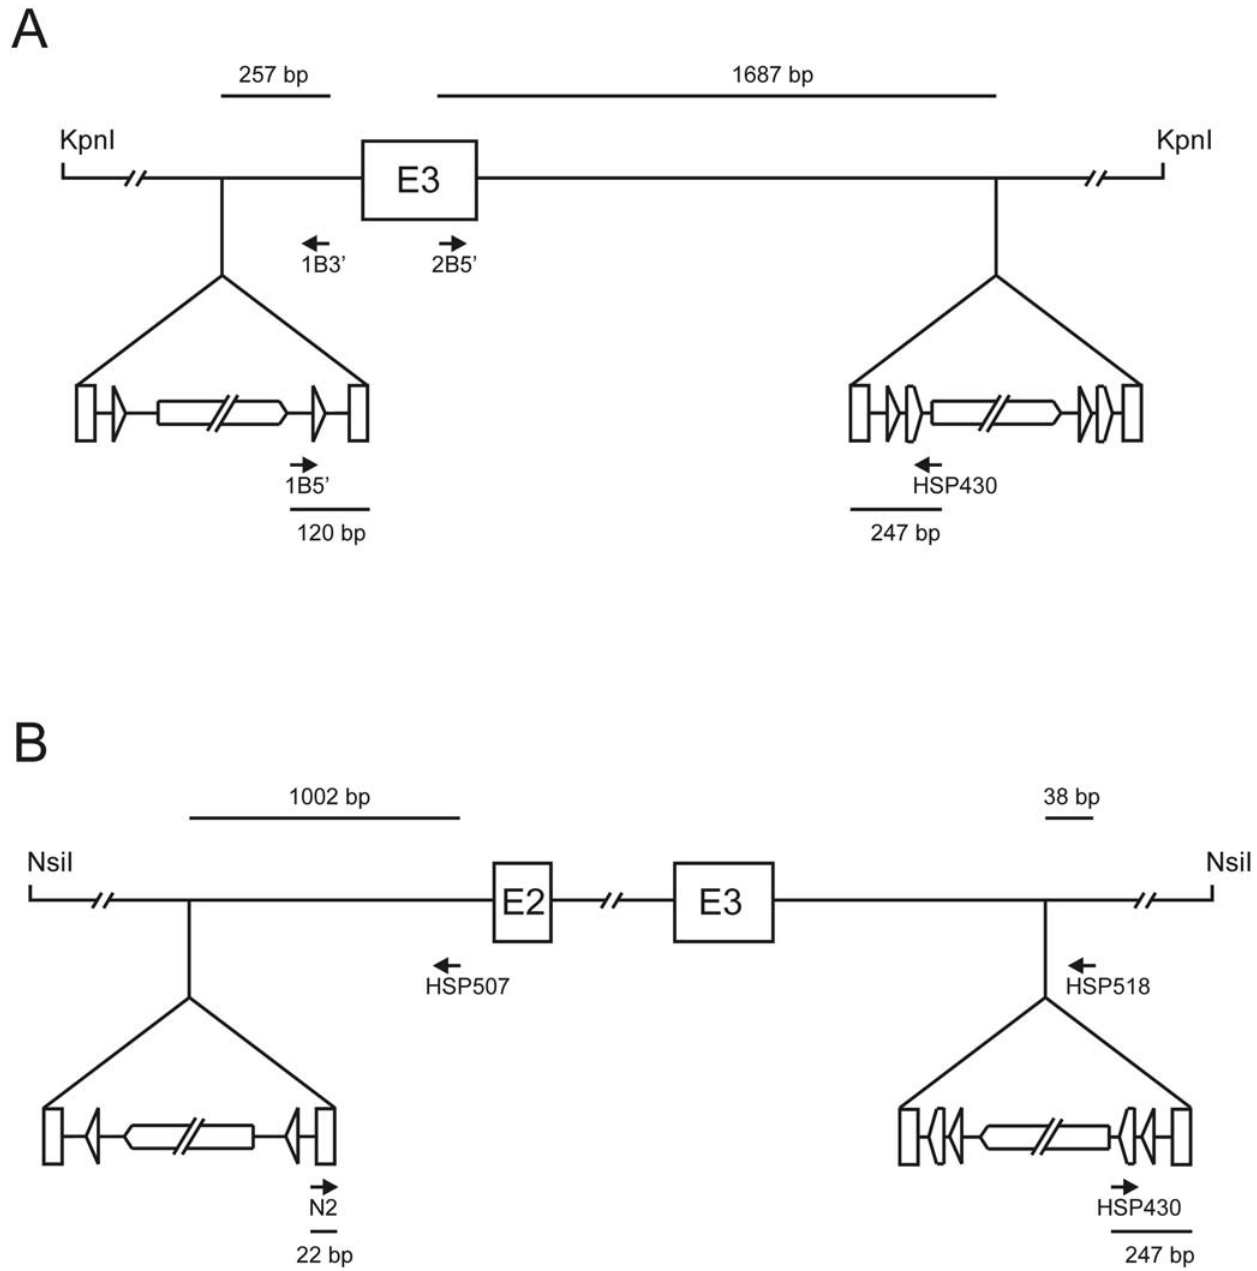
Figure 3. PCR screening of transposon-containing plasmid clones. ( A ) Cdh22 locus. The first transposon insertion was screened using the primer pair 1B5 9 /1B3 9 . The second transposon insertion was screened using the primer pair 2B5 9 /HSP430. ( B ) Drapc1 locus. The first transposon insertion was screened using the primer pair N2/HSP507. The second transposon insertion was screened using the primer pair HSP430/HSP518. In both panels, the relevant distances from the identified transposon insertion site to the 5 9 ends of the primers are shown in base pairs (bp). For the sake of clarity, figure elements are not drawn in scale.